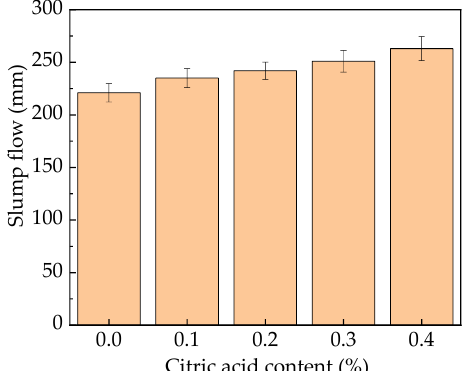
Figure 3. The slump flow of the fresh MOS paste.